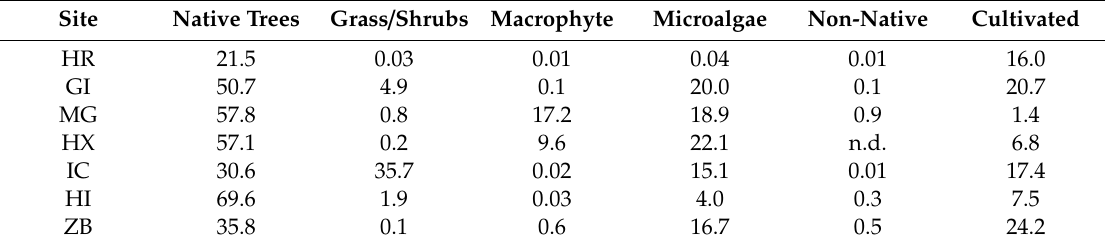
Table 3. Percentage (%) contribution of native terrestrial and aquatic plants, versus non-native and cultivated species to the total eDNA pool of the soil of seven forested floodplain wetlands. The full names and location of the sampling sites can be found in Table 1 and Figure 1. Site Native Trees Grass / Shrubs Macrophyte Microalgae Non-Native